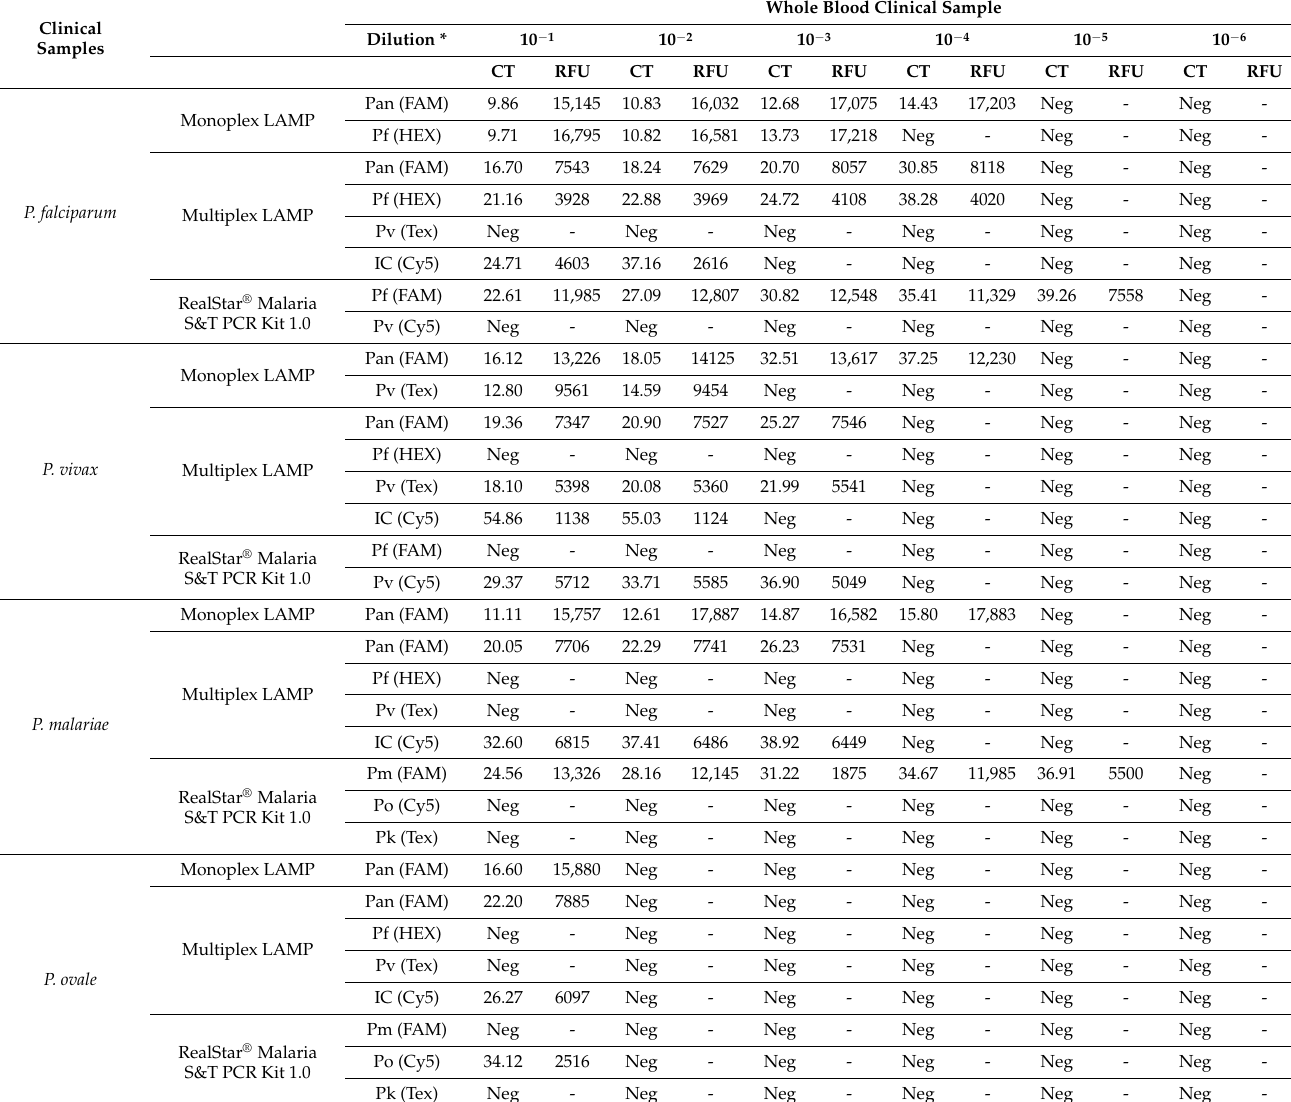
Table 3. Limit of detection (LOD) tests for monoplex and multiplex malaria Pan/Pf/Pv/IC LAMP assays and RealStar